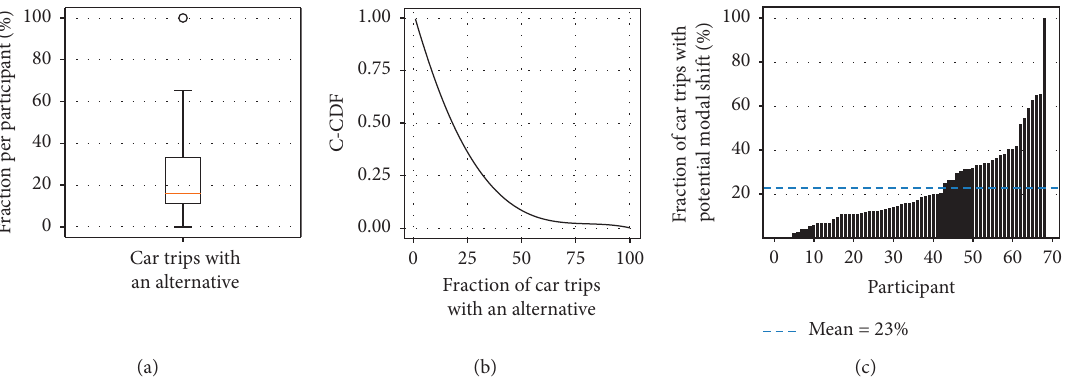
Figure 21: Range and distribution of per-traveler possibilities of time-relevant low-carbon modal